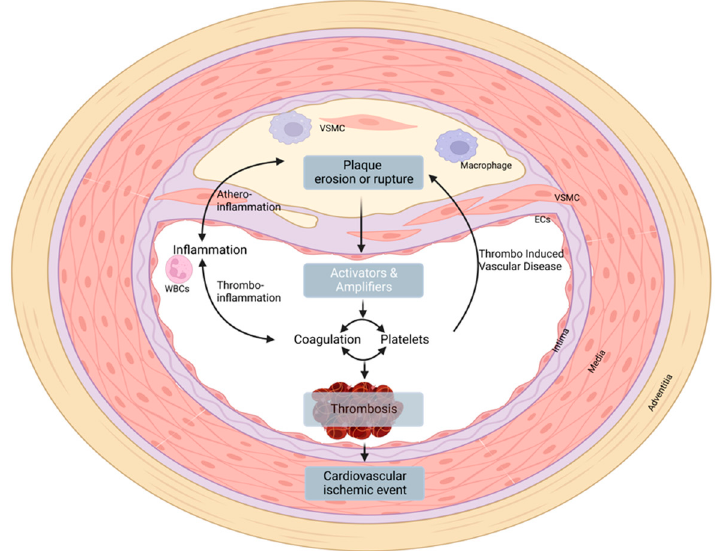
Figure 1. Schematic representation of interactions between atherosclerosis, inflammation, and thrombosis in peripheral arterial disease. Inflammation initiates or stimulates the development and progression of atherosclerosis, while the atherogenic process triggers inflammation (the athero-inflammation axis), which acts as key modulator of thrombosis (the thrombo-inflammation axis). Plaque and vascular components trigger the activation of platelets and the coagulation system, leading to thrombus formation. Activated platelets and ongoing coagulation further enhance inflammation, thereby indirectly influencing atherosclerosis. The direct effects of active coagulation factors and activated platelets on atherosclerosis are depicted in the “thrombo-induced vascular disease axis”, in which coagulation proteases directly affect atherogenic cells such as macrophages, smooth muscle cells, and endothelial cells. Created with Biorender.com (accessed on 10 October